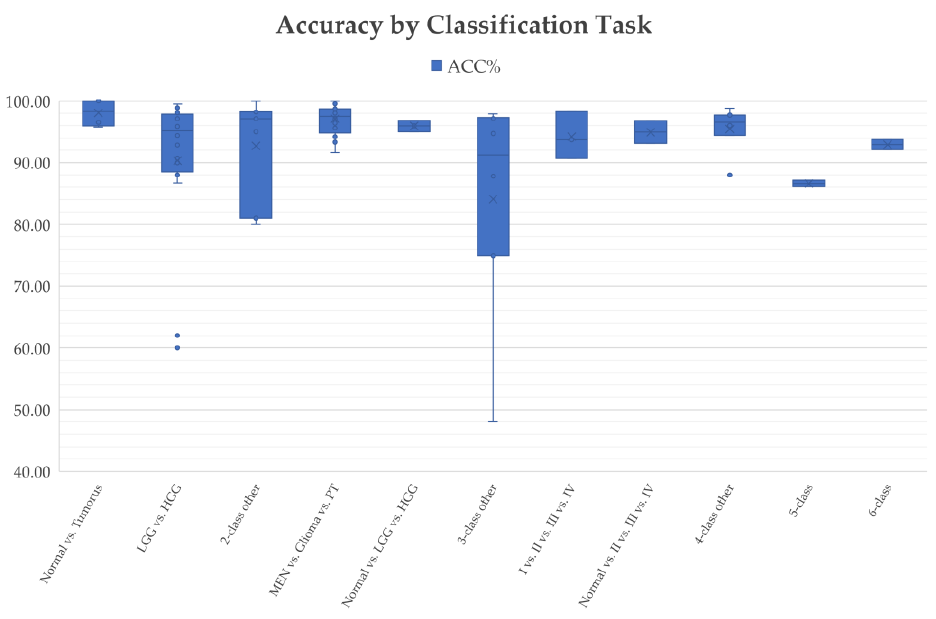
Figure 8. Classification accuracy by classification task.